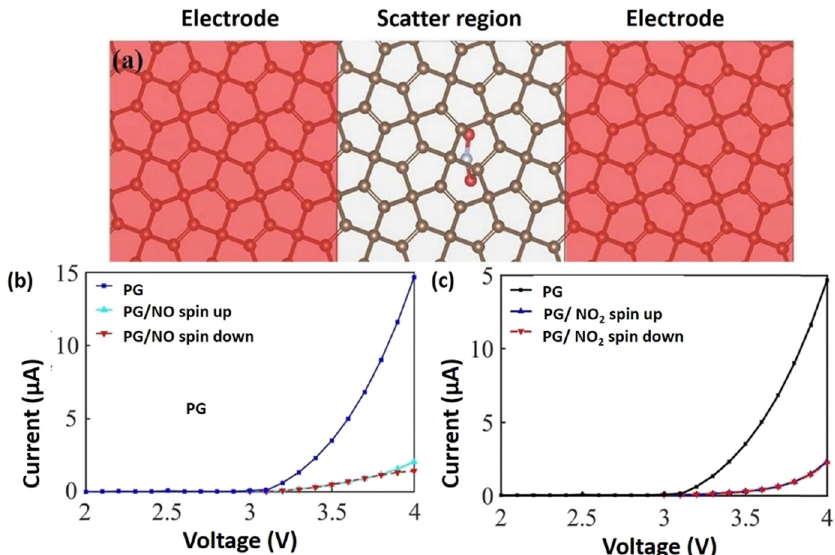
Figure 7: ( a ) Illustration of the two - probe systems of semi - in fi nite left and right electrode regions ( red shaded region ) which are in contact with the central scattering region of PG ( b ) and ( c ) display the I – V curves of PG and PG with the NO and NO 2 adsorption. Reproduced from ref. [ 104 ]